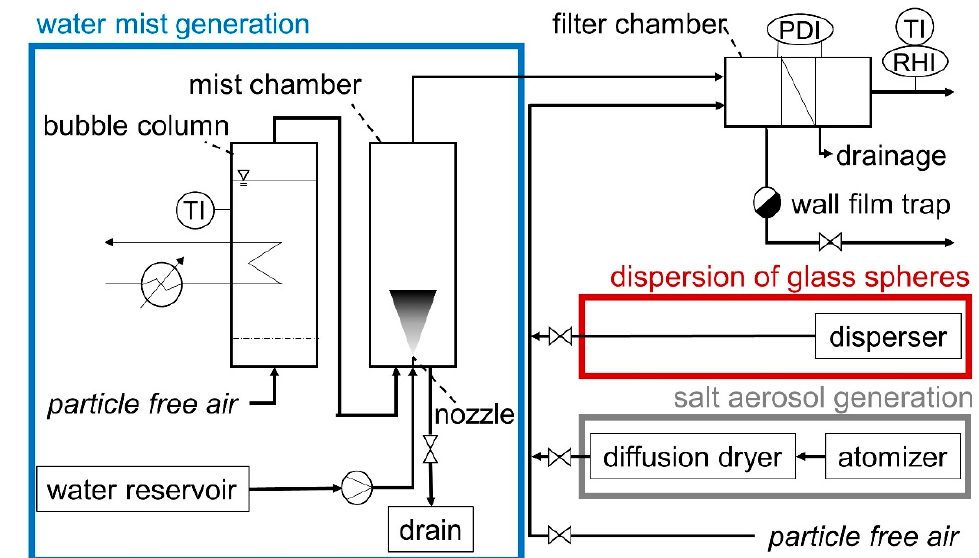
Figure 2. Experimental setup including particle generation, water mist generation, and filter chamber.